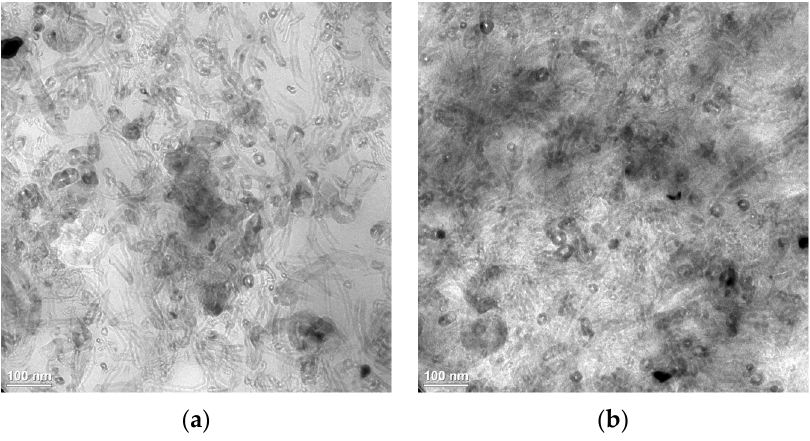
Figure 3. TEM micrographs of a section for nanocomposites of iPP MFI = 2.5 /MNT (10 wt % fabricated by melt extrusion ( a ) without, and ( b ) with, V ‐ U ultrasound ‐ assist fabrication.